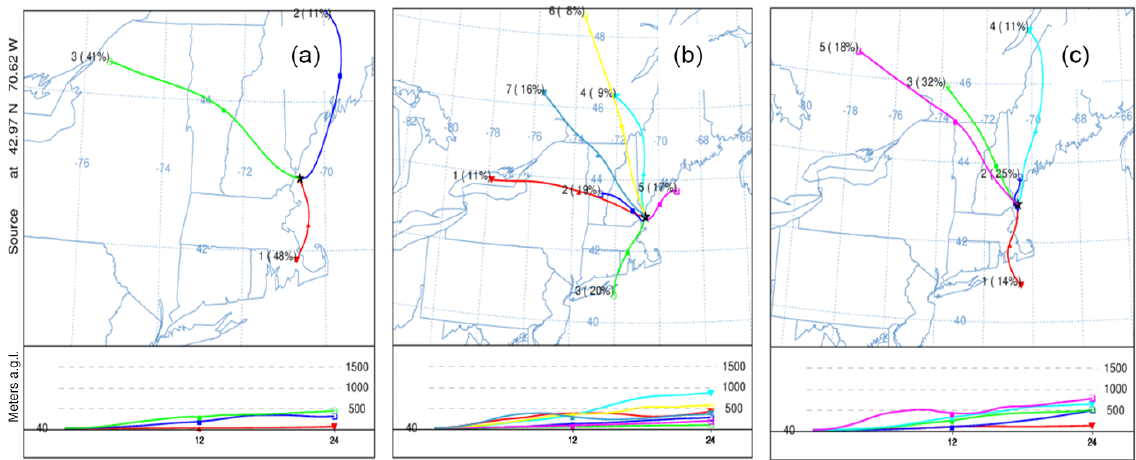
Figure 5. Clustered 24h back trajectories of air masses in (a) overestimation cases, (b) matching cases, and (c) underestimation cases at